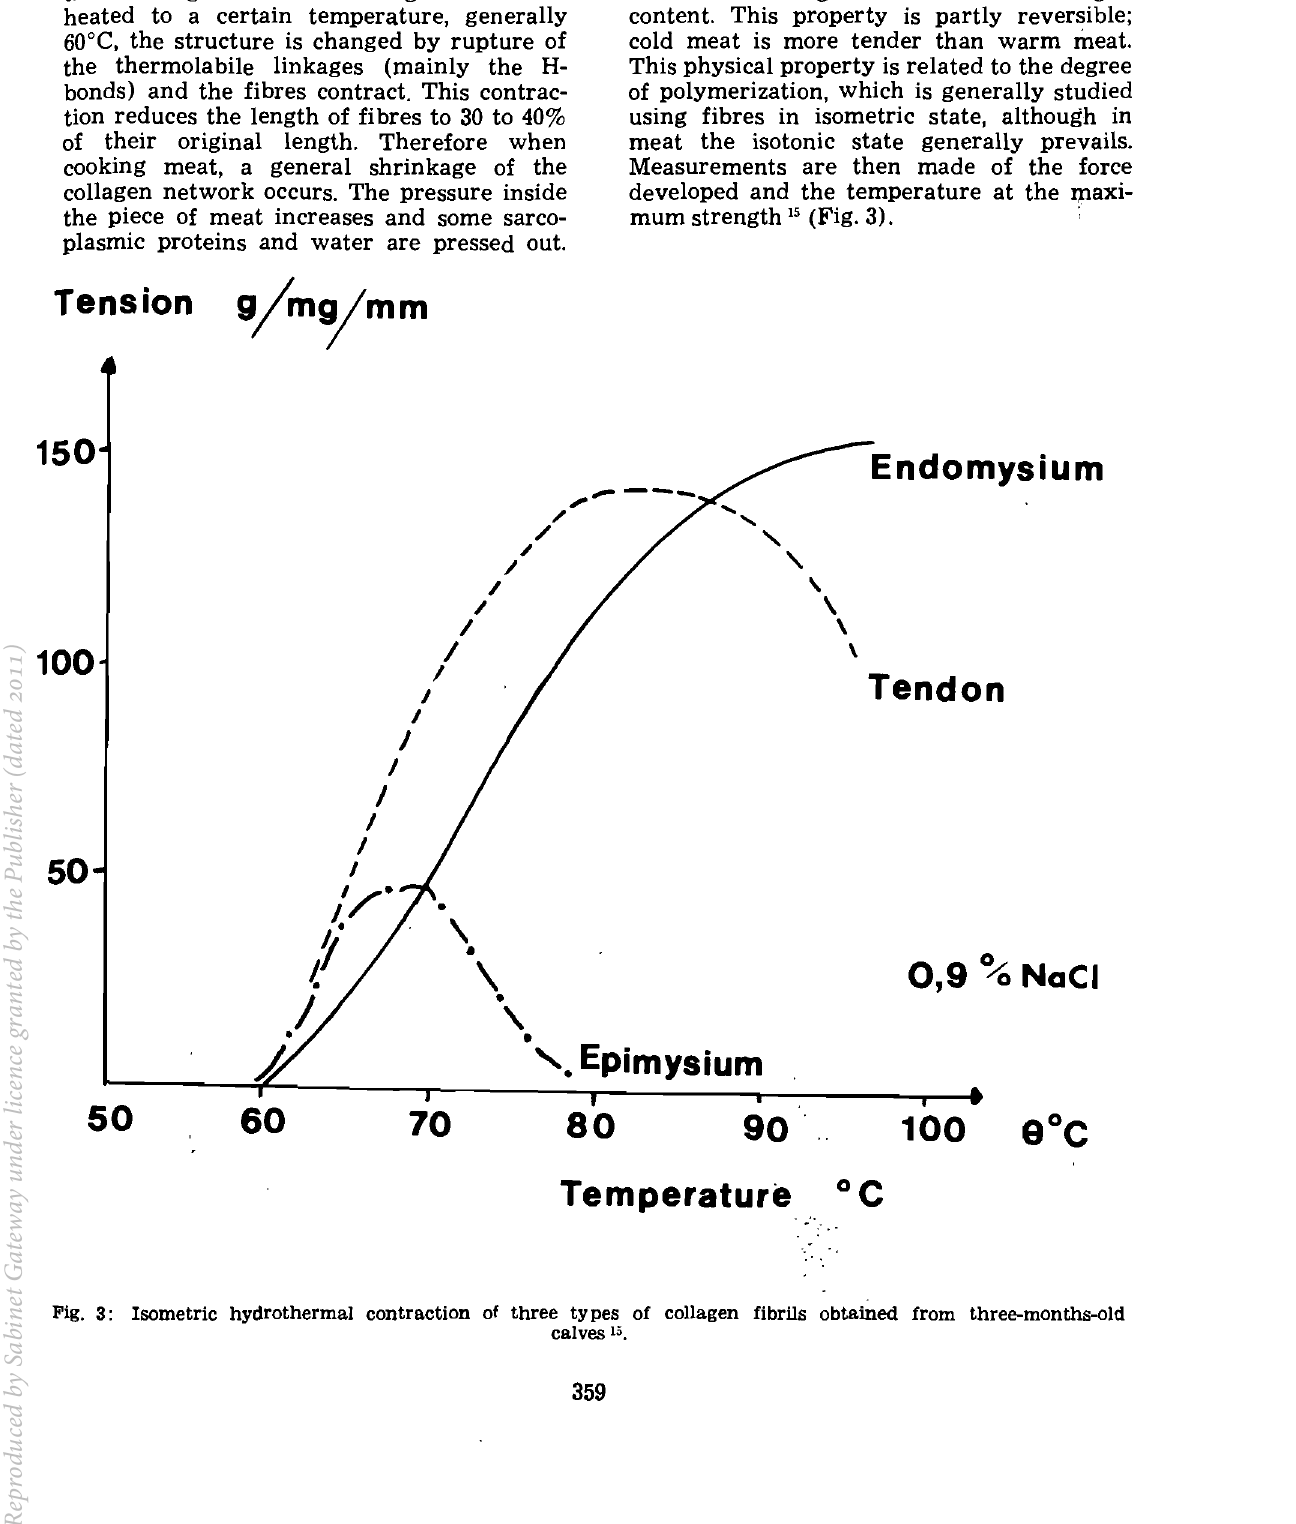
Fig. 3: Isometric hydrothermal contraction of three ty pes of collagen fibrils obtained from three-months-old calves 15.